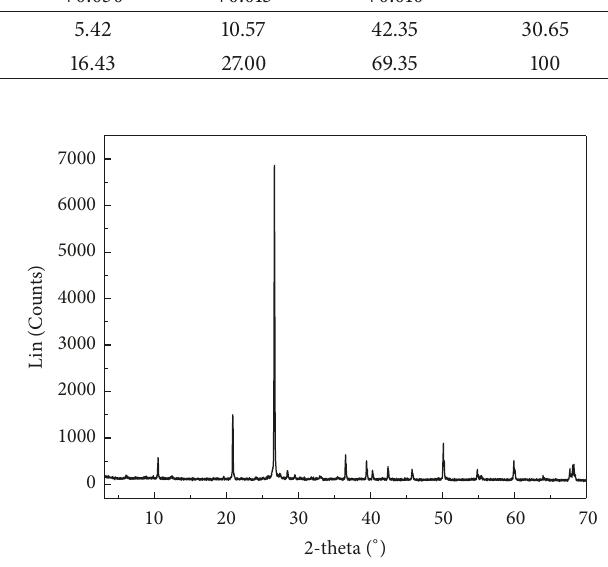
Figure 1: XRD analysis of the HIMS tailings